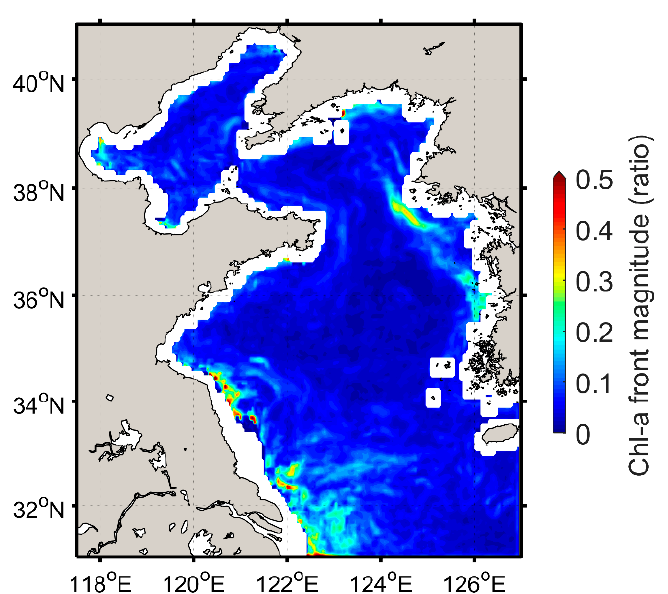
Figure 5. The standard deviation of the chl-a front in summer from 2002 to 2016.